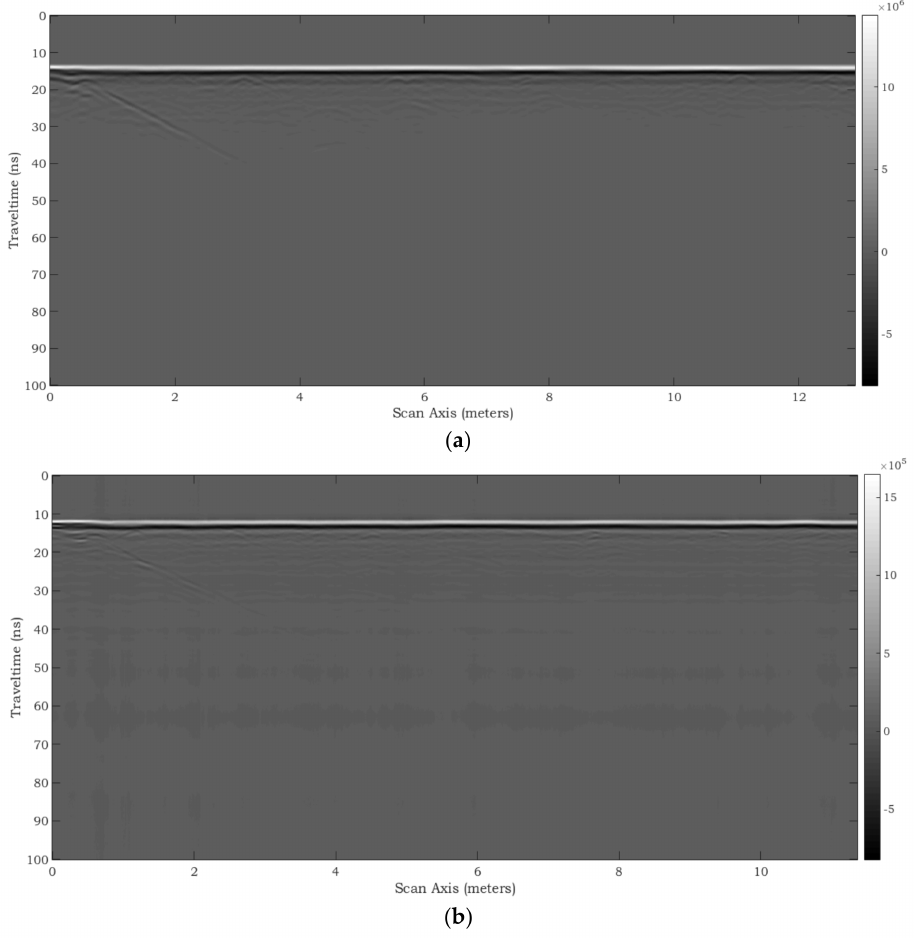
Figure 26. Profiles recorded in the limestone region by using GPR 1, on acquisition line 2, with ‘new’ antennas operating at: ( a ) 400 MHz; ( b ) 900